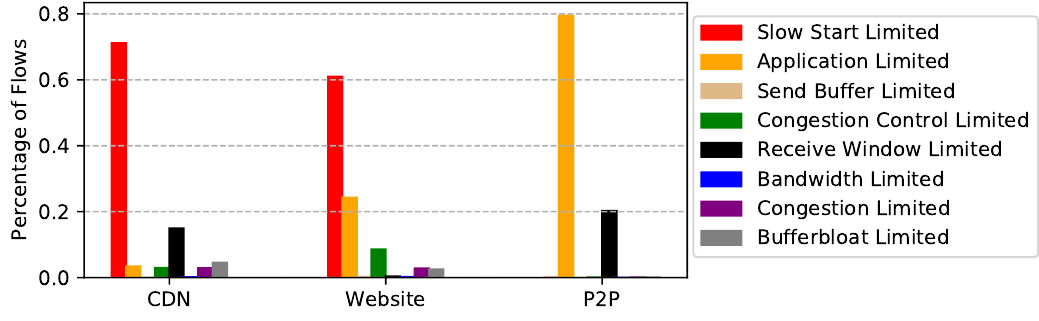
Figure 8. Percentage of flows for each limiting factor.